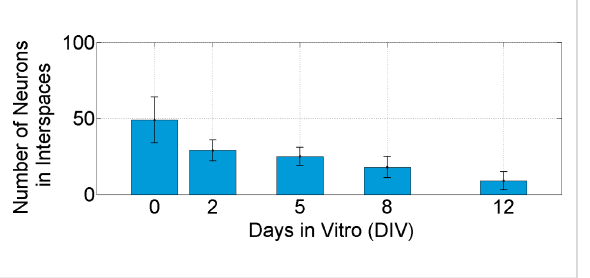
Figure 4: Development of the number of neurons in the interspace regions of the spatially oriented CNTs.